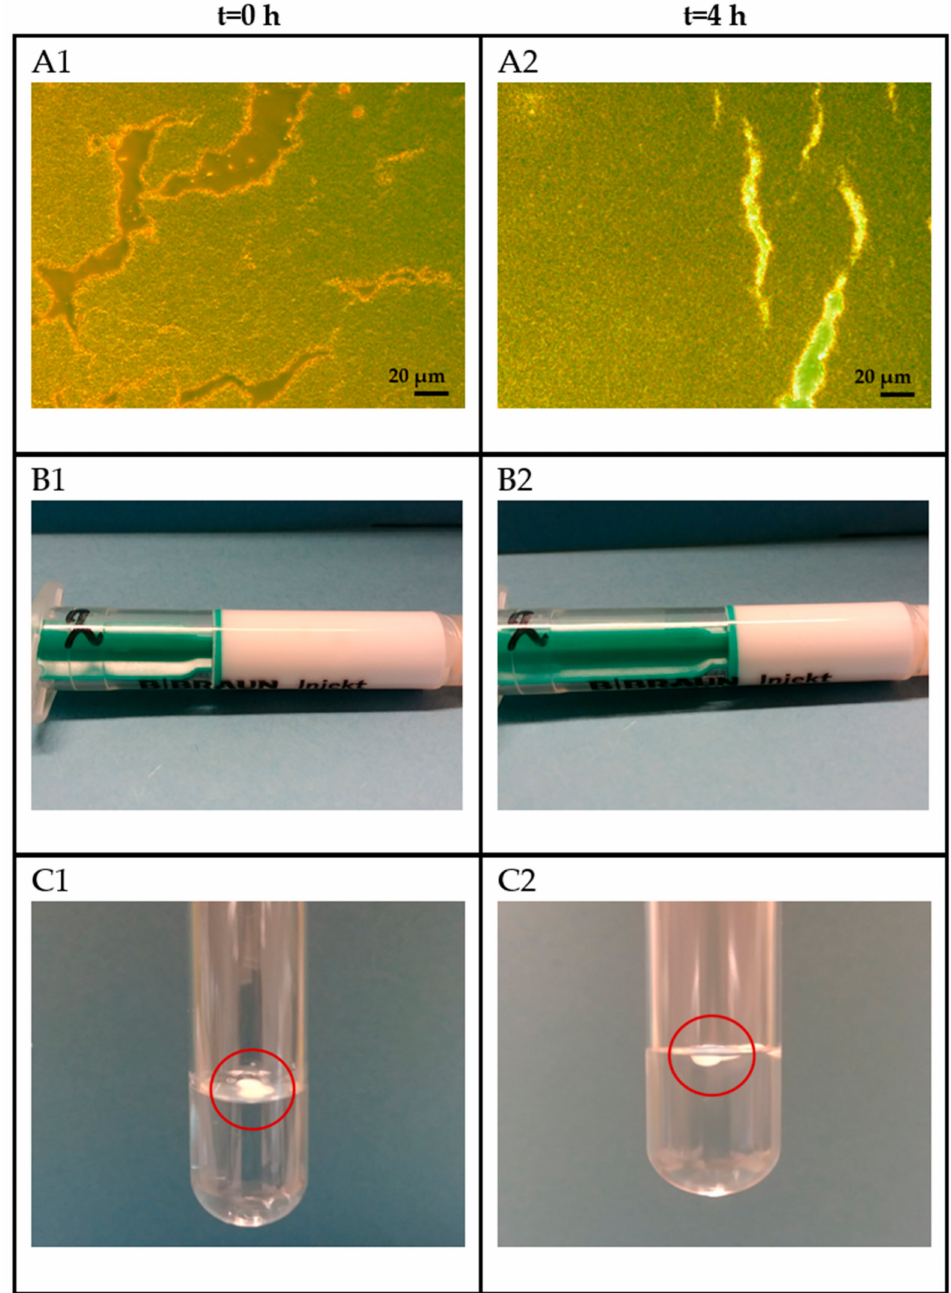
Figure 5. Representative images from the 4-h emulsion stability study at room temperature. ( A1 , A2 ): Microscopic examination at 20 × magnification. ( B1 , B2 ): Visual inspection of the emul- sion stored in the syringe. ( C1 , C2 ): The water-drop test to investigate potential phase separation of the water-in-oil emulsion. The red circle shows the emulsion droplet on the surface of the water without any emulsion phase